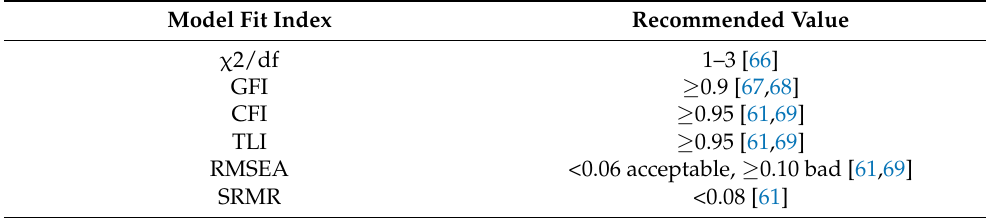
Table 3. Recommended Values for Model Fit Indexes.